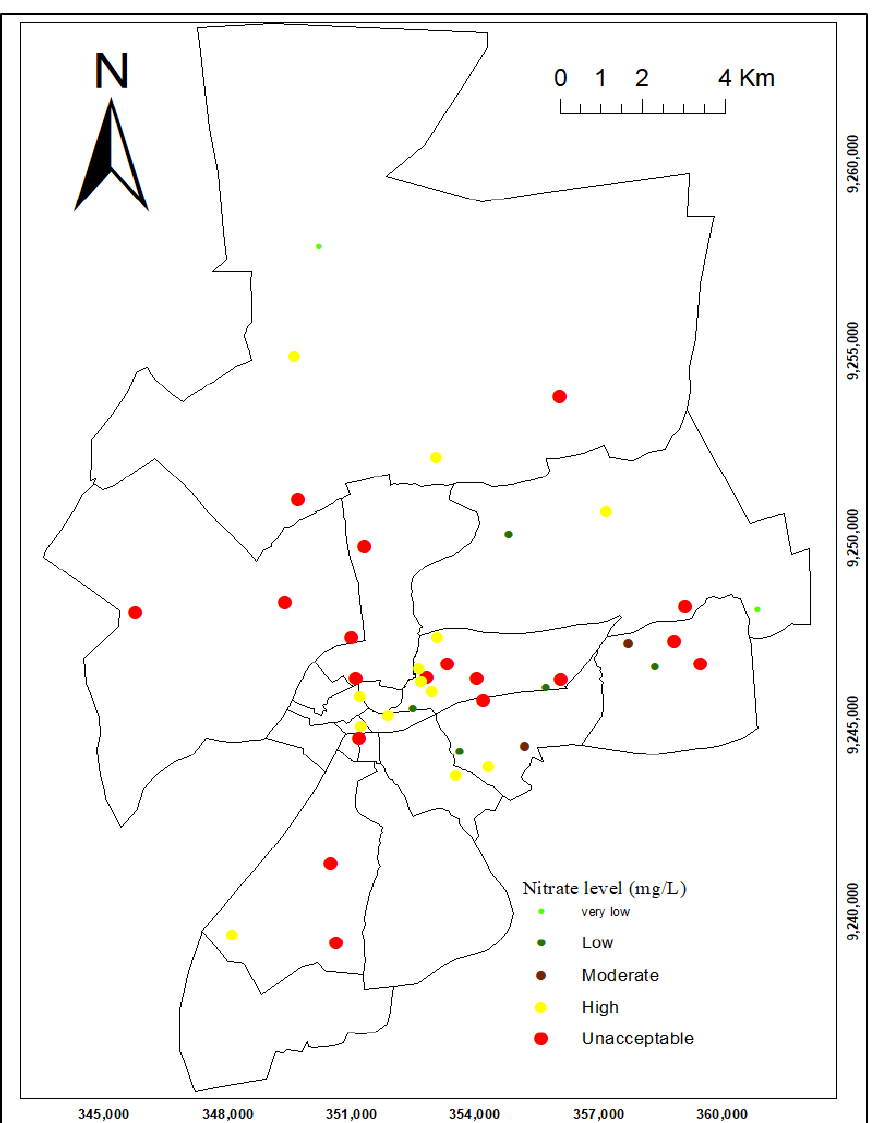
Figure 13. Spatial distribution of nitrate and classification map: very low (<5 mg/L), low (5 – 13 mg/L), moderate (14 – 28 mg/L), high (29 – 50 mg/L) and unacceptable (>50 mg/L).